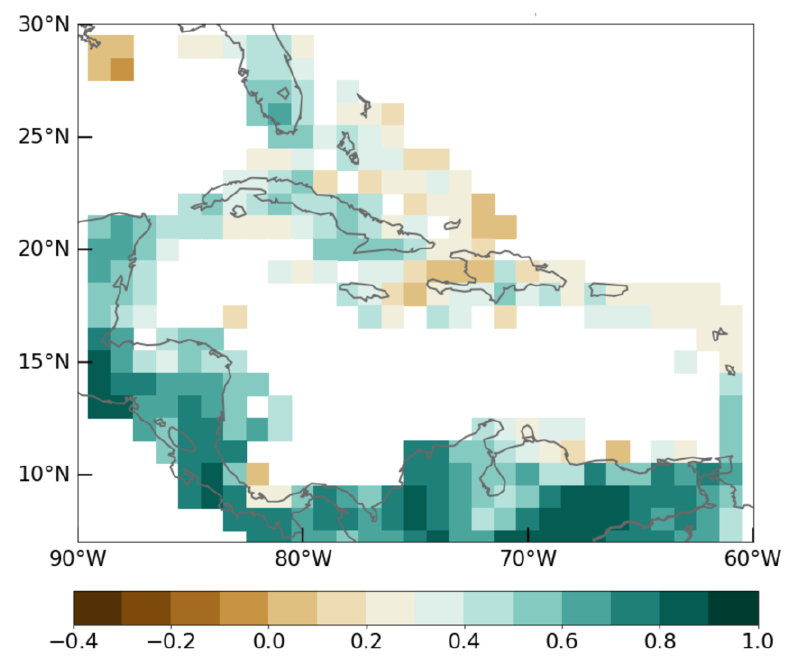
Figure 6. Correlation between full data GPCCversion 8 and version 7 over the period 1983–2000. The products were used with a native spatial resolution of 1° × 1°.